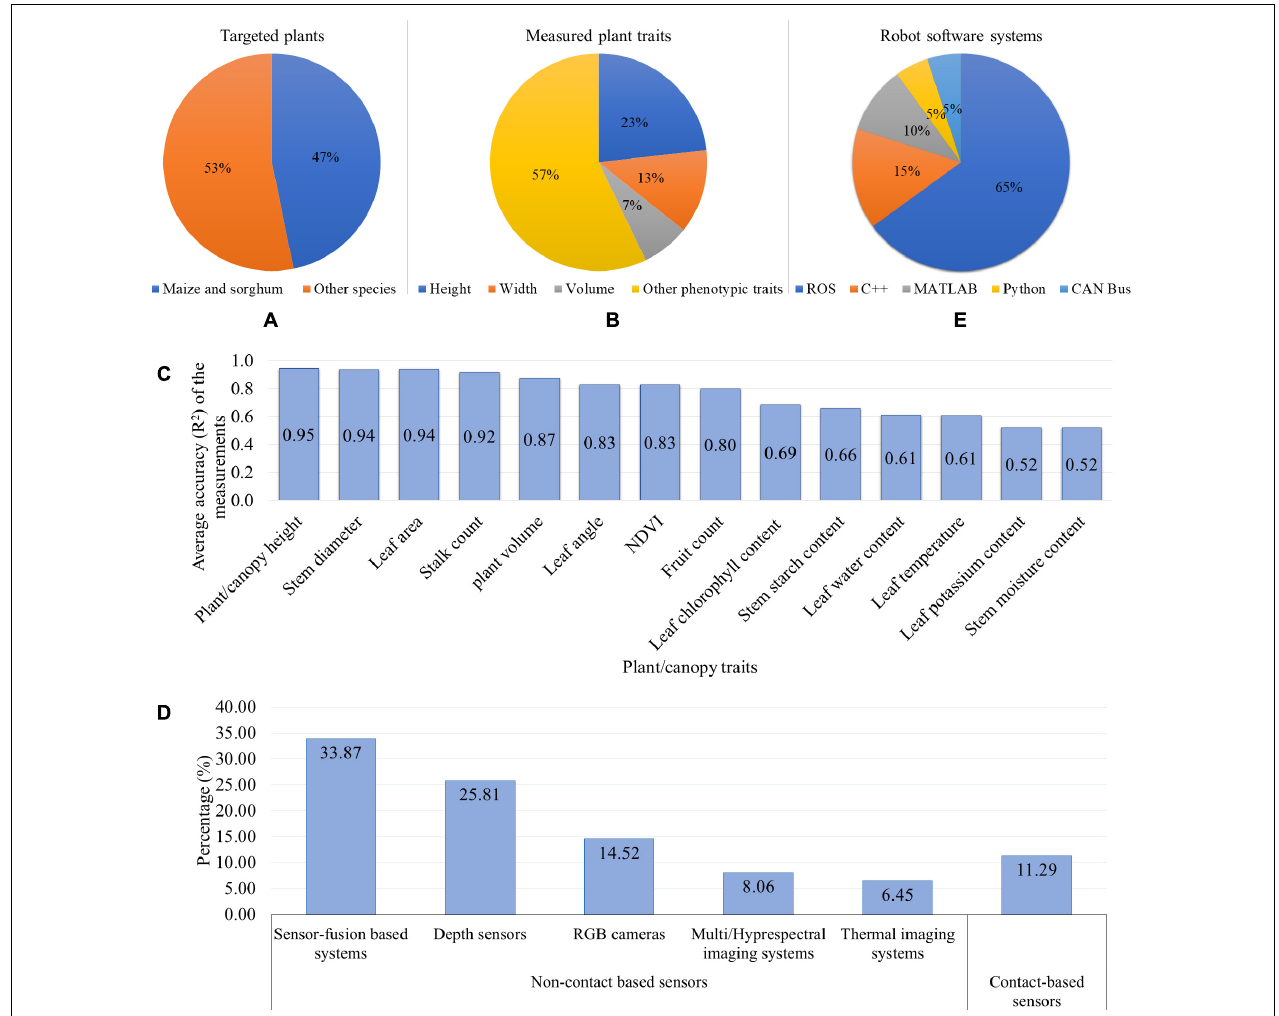
FIGURE 4 | Summary statistics of the phenotyping robotic systems: (A) Targeted plants, (B) Plant/canopy traits measured by the robots, (C) Average accuracy ( R 2 ) to measure the phenotypic traits, (D) Robot vision/sensing systems, and (E) Robot software